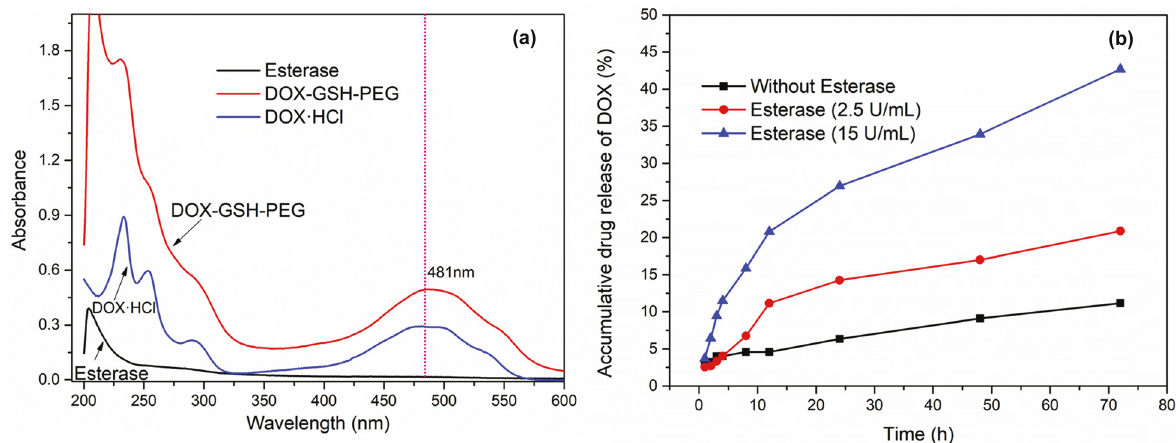
Figure 3: ( a ) The UV - Vis curves of esterase, DOX · HCl, and DOX - GSH - PEG in PBS and ( b ) the accumulative drug release rate of DOX from DOX - GSH - PEG in PBS ( pH = 6.0 ) with esterase environment.